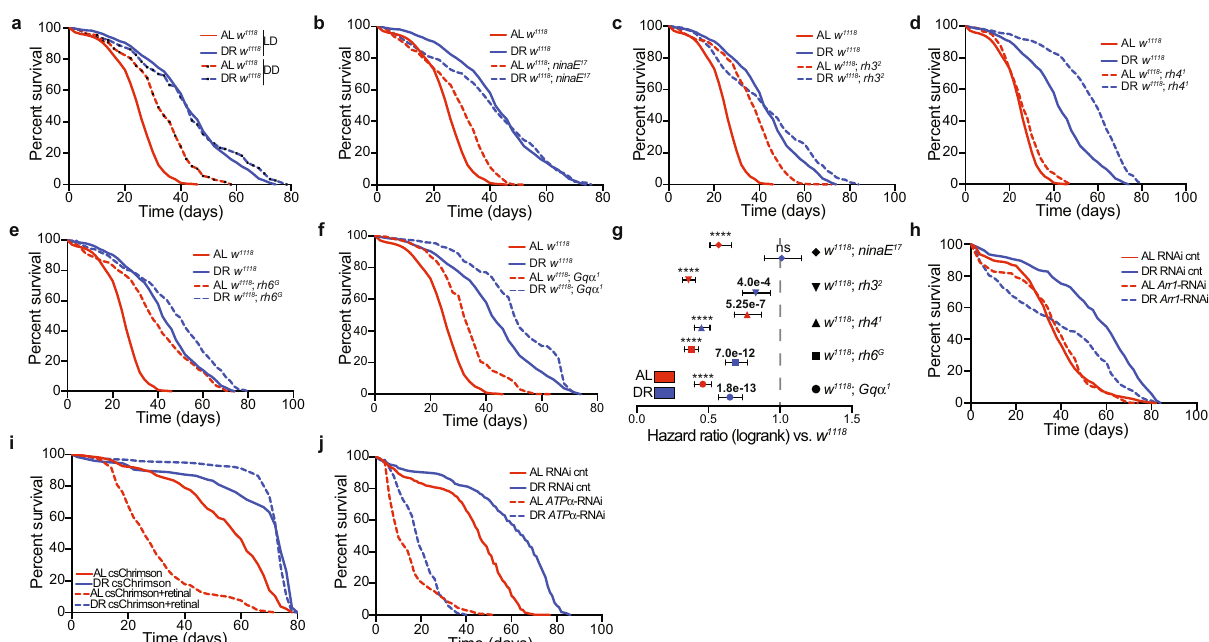
Fig. 5 Photoreceptor activation modulates lifespan in a diet-dependent fashion. a Survival analysis of w 1118 fl ies housed in 12:12 h LD or constant darkness (DD). Survival data are plotted as an average of three independent lifespan repeats. b – f Survival analysis of w 1118 ; ninaE 17 , w 1118 ; rh3 2 , w 1118 ; rh4 1 , w 1118 ; rh6 G , and w 1118 ; Gq α 1 mutants compared to w 1118 control fl ies housed in 12:12 h LD. Survival data are plotted as an average of three independent lifespan repeats. *Survival curves for w 1118 are re-plotted ( b – f ) for visual comparison, and the w 1118 and rhodopsin-null lifespans repeats were performed simultaneously. All mutant lines were outcrossed to w 1118 . g Hazard ratios for rhodopsin and Gq mutant fl ies compared to w 1118 control fl ies (ratios < 1 indicate fl ies that are more likely to survive compared to w 1118 ). The hazard ratio for each strain is plotted as the measure of centre and the error bars indicate the 95% con fi dence interval of the hazard ratios. P -values were determined by Log-rank (Mantel-Cox) test, ns denotes a non-signi fi cant P -value, **** indicates P ≤ 1.0e-15. h Survival analysis of eye-speci fi c arr1 -RNAi knockdown fl ies vs RNAi control fl ies. Survival data are plotted as an average of two independent lifespan repeats for arr1 -RNAi and one independent lifespan replicate for RNAi-controls. i Survival analysis of retinal inducible, photoreceptor-speci fi c optogenetic fl ies (Trpl-GAL4> UAS-csChrimson [red-shifted]) supplemented with retinal or vehicle control and housed in 12:12 h red light:dark. Survival data are plotted as an average of two independent lifespan repeats. j Survival analysis of eye-speci fi c ATP α RNAi knockdown fl ies vs RNAi control fl ies. Survival data are plotted as an average of three independent lifespan repeats. The total number of fl ies ( N ) corresponding to each lifespan in Fig. 5 can be found in the “ Statistics and Reproducibility ” section within the Methods. Source data are provided as a Source Data fi